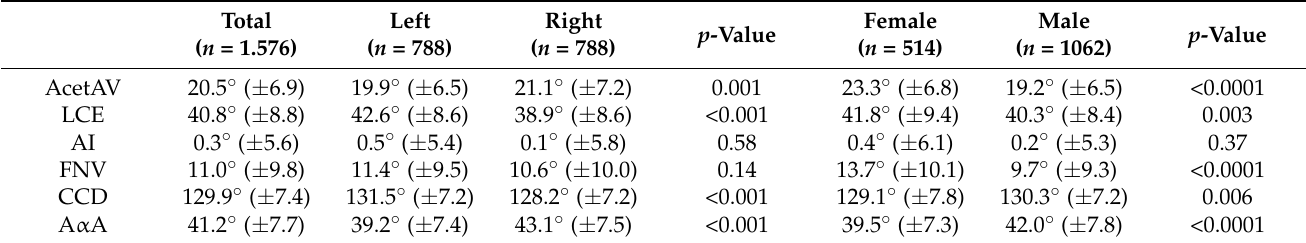
Table 2. Mean values of acetabular and femoral morphological parameters, according to side and